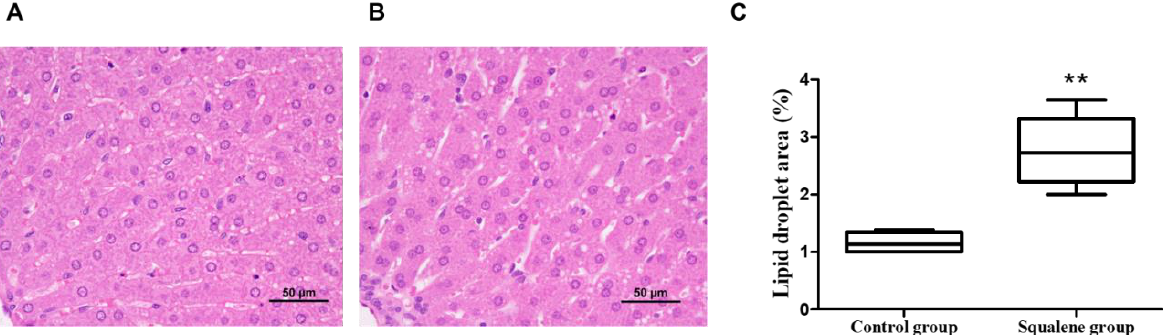
Figure 2. Hepatic histological analyses in rabbits fed with different diets. Representative liver micrographs when consuming control containing sunflower-oil diet ( A ) vs. 0.6 g/kg squalene-enriched control diet ( B ). Liver sections from each animal were stained with hematoxylin and eosin and evaluated blindly. Morphometric difference in amount of lipid droplet area in both control and squalene groups ( C ). Data are means and 10–90 percentiles for each group. Statistical analyses were performed according to Mann–Whitney’s U-test. **, p < 0.01.